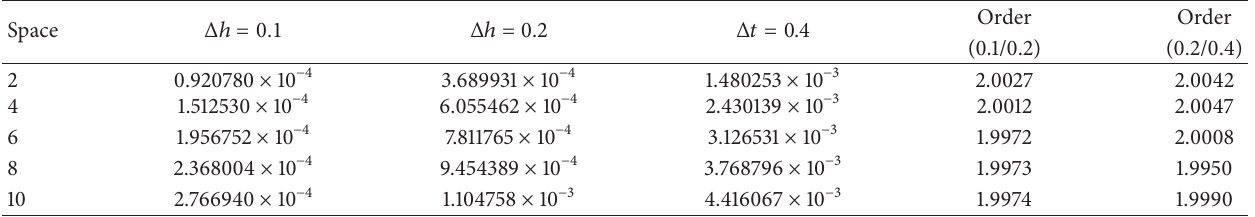
Table 7: The order of convergence in space for 𝐿 ∞ error norm with 𝑘 = 0.01 and 𝑐 = 0.3 .